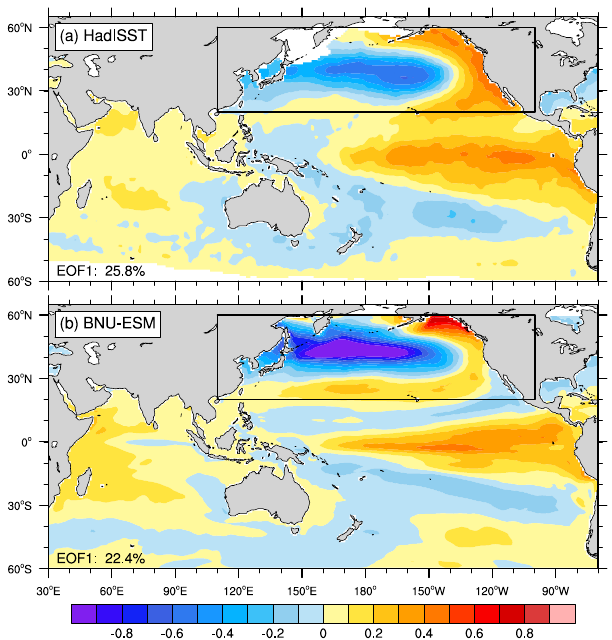
Figure 21. Leading EOF of monthly SST anomalies for the North Pacific domain (outlined by the box) for HadISST and the BNU- ESM historical run over the period 1900–2005. The results are shown as SST anomaly regressions upon the normalized principal component time series ( ◦ C per standard deviation). The numbers at the bottom left corner of each panel denote the percentage of vari- ance explained by the leading EOF.